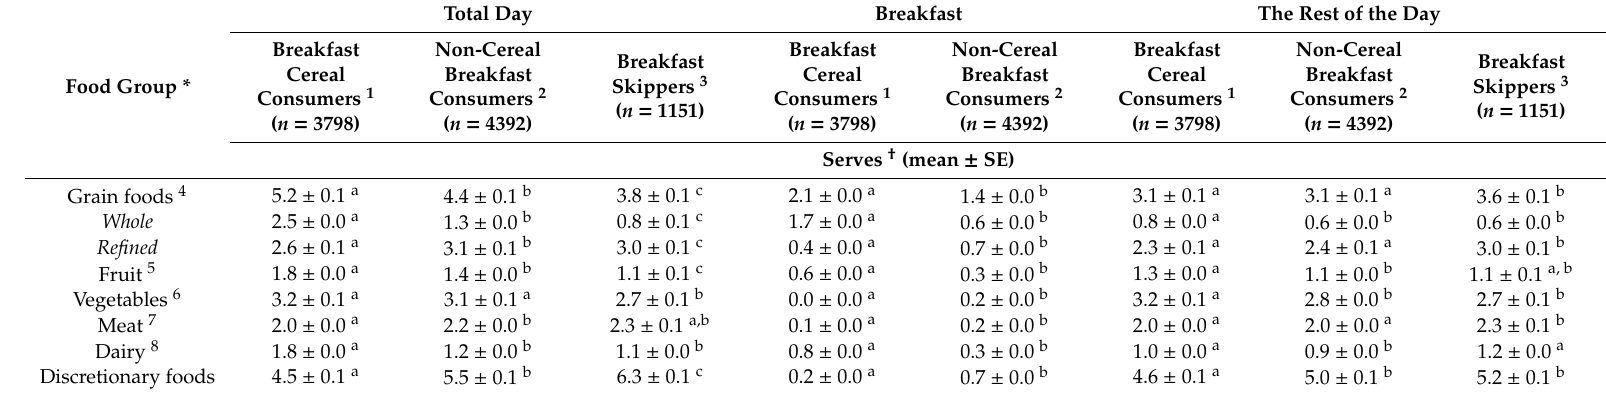
Table 3. Serves of the Five Food Groups and discretionary foods at breakfast, the rest of the day, and the total day by breakfast consumer